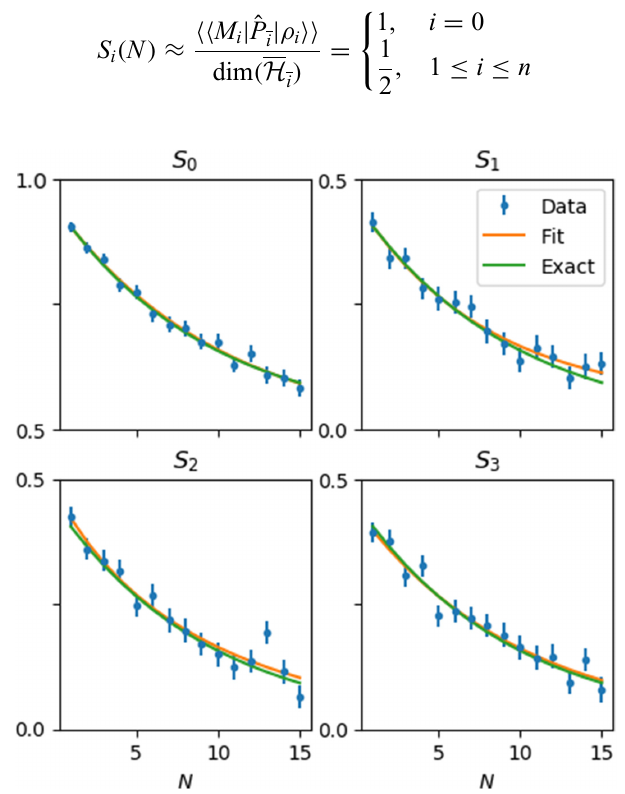
FIG. 7. The predicted and measured character-weighted sur- vival probability for a random error channel. The exact decay (green) is an exponential decay given by one of Eq. (23). We estimate S i ( N ) by applying random gates and measuring the final state (blue points). The data is fit to an appropriate function (orange) from which we estimate the fidelity.